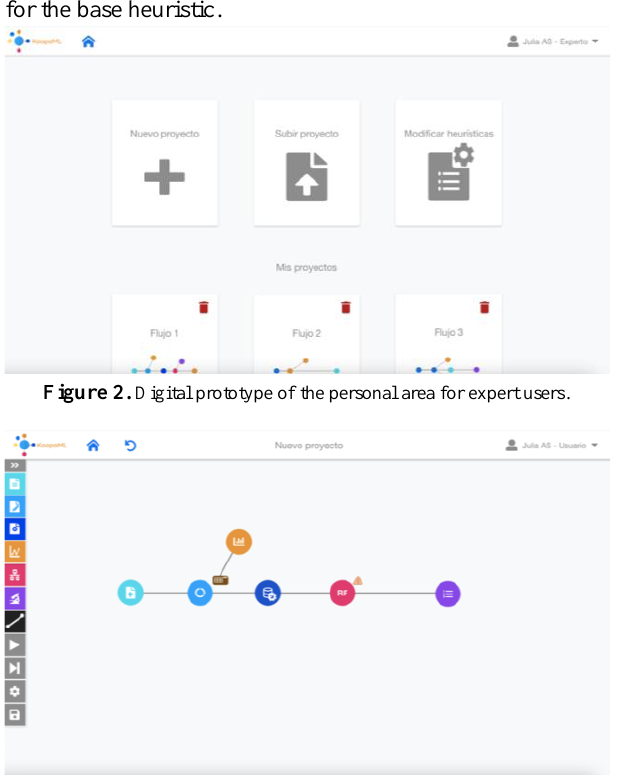
Figure 3. Digital prototype of a pipeline with different tasks